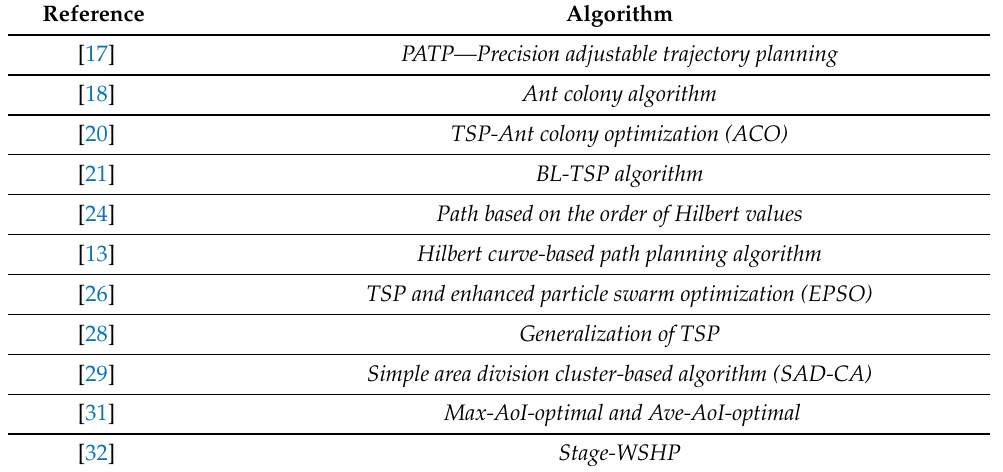
Table 2. Algorithms used in